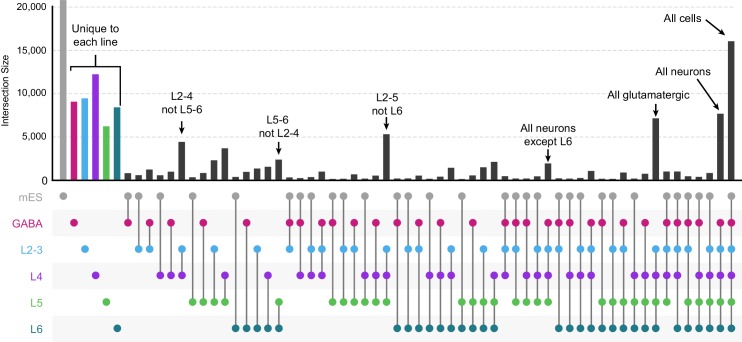
Intersections among peak sets derived from different cell classes.We first derived a merged peak set by Diffbind for all peaks identified in all cell classes. We counted how often each merged peak overlapped peaks called for all 3 replicates of each cell class, then calculated the frequency with which each peak was found in every combination of cell classes. We plotted these frequencies using the UpSetR package for R. We find many genomic regions that are unique to each cell class, and others that are shared among various cell classes.